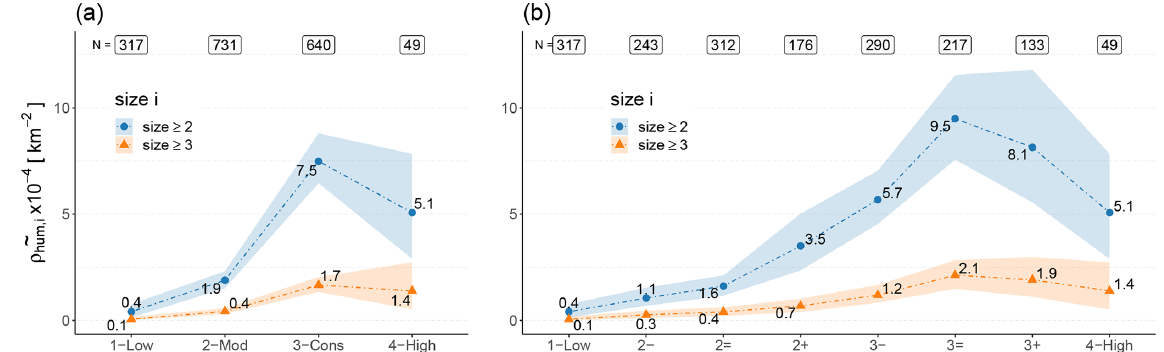
Figure A2. The density of human-triggered avalanches (or the number relative to the surface area) compared to (a) the danger level D and (b) the sub-level D sub . Shown are the median values (points) and the 95% confidence interval (shaded area). N represents the number of danger regions. Here, we restricted the analysis to cases when the same D sub was forecast for regions with approximately similar A PRA . The resulting median A PRA was between 2000 and 2300km 2 for each D sub